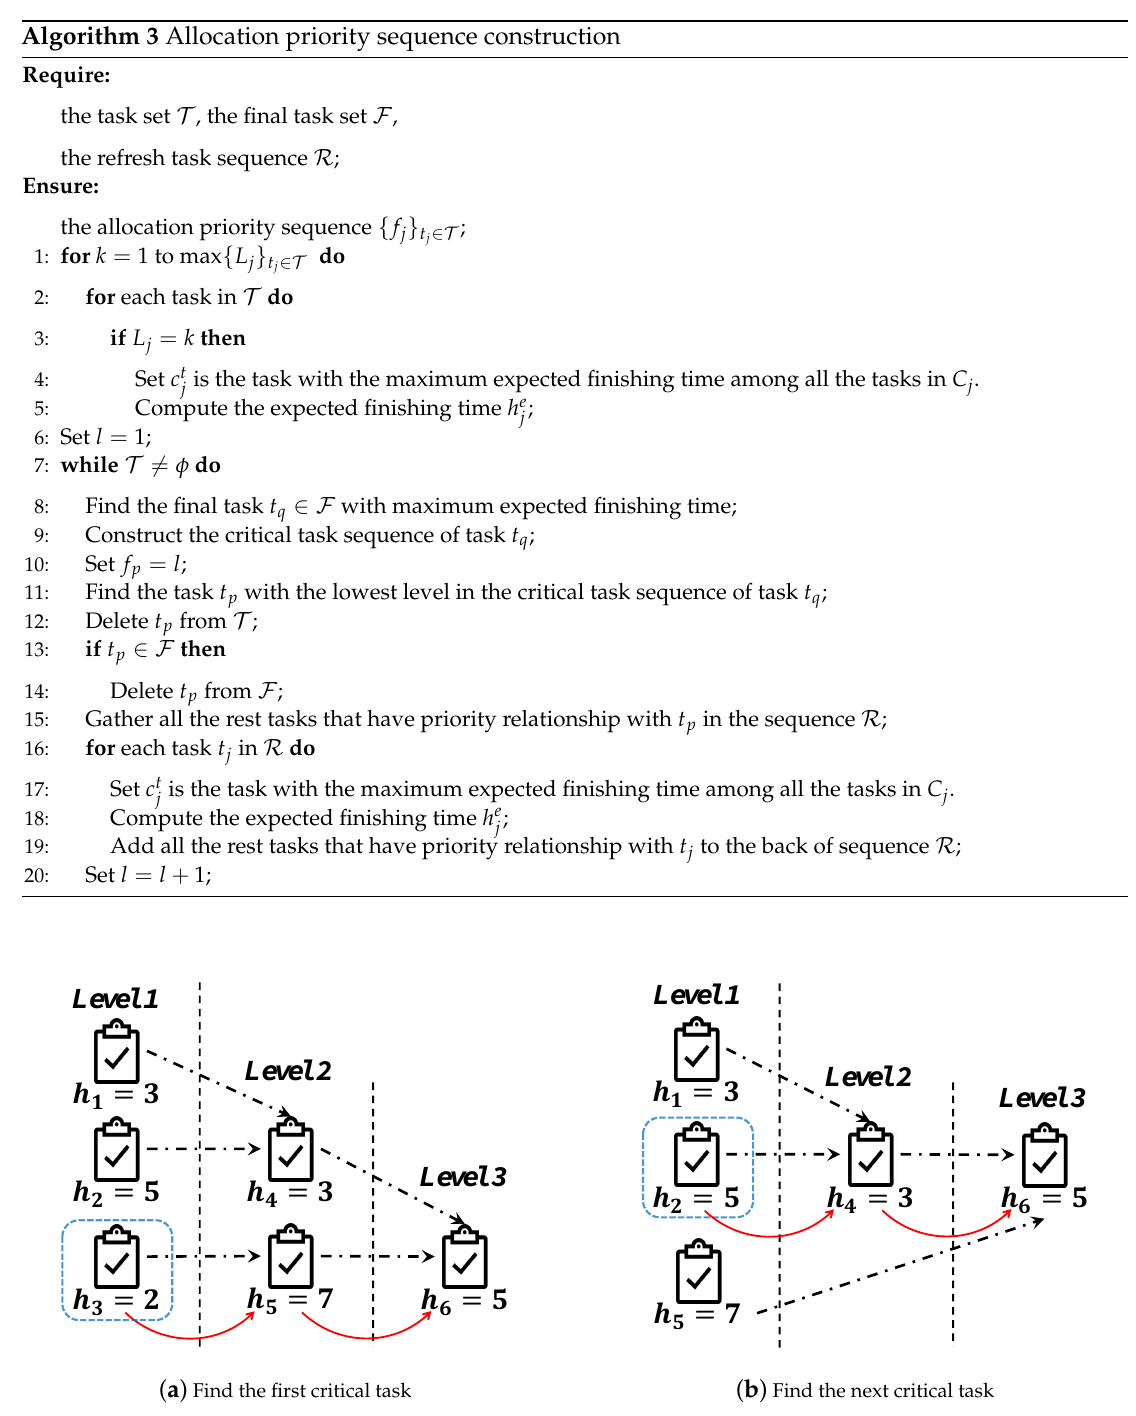
Figure 3. The instance for Algorithm